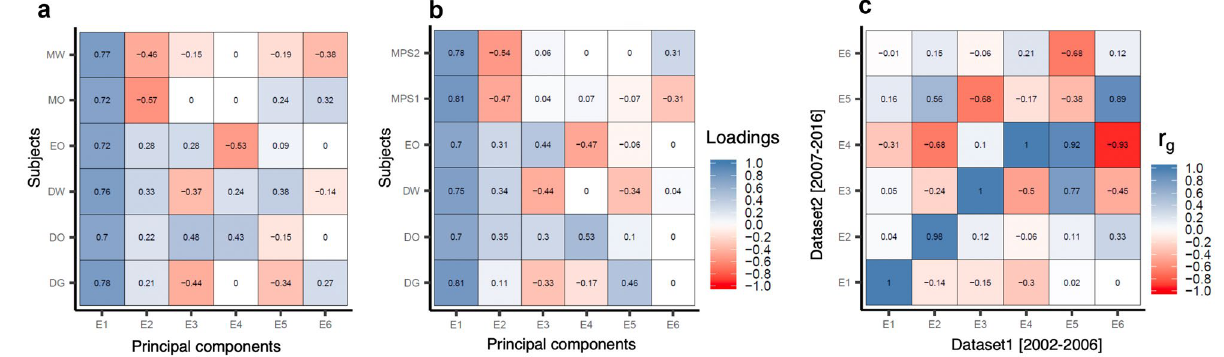
Figure 1. PC loadings and genetic correlations of E-factors. ( a ) Pearson correlations between the first 6 PCs and subject-specific grades in dataset 1 (i.e., based on exams conducted between 2002 and 2006; N=11,284); ( b ) Pearson correlations between the first 6 PCs and subject-specific grades in dataset 2 (i.e., based on exams conducted between 2007 and 2016; N=19,698); ( c ) Pairwise genetic correlations (r g ) between dataset 1 PCs and dataset 2 PCs estimated using GCTA bivariate GREML analysis; DG Danish grammar, DO Danish oral, DW Danish written, EO English oral, MO Math oral, MW Math written, MPS1 Math problem solving 1 (with